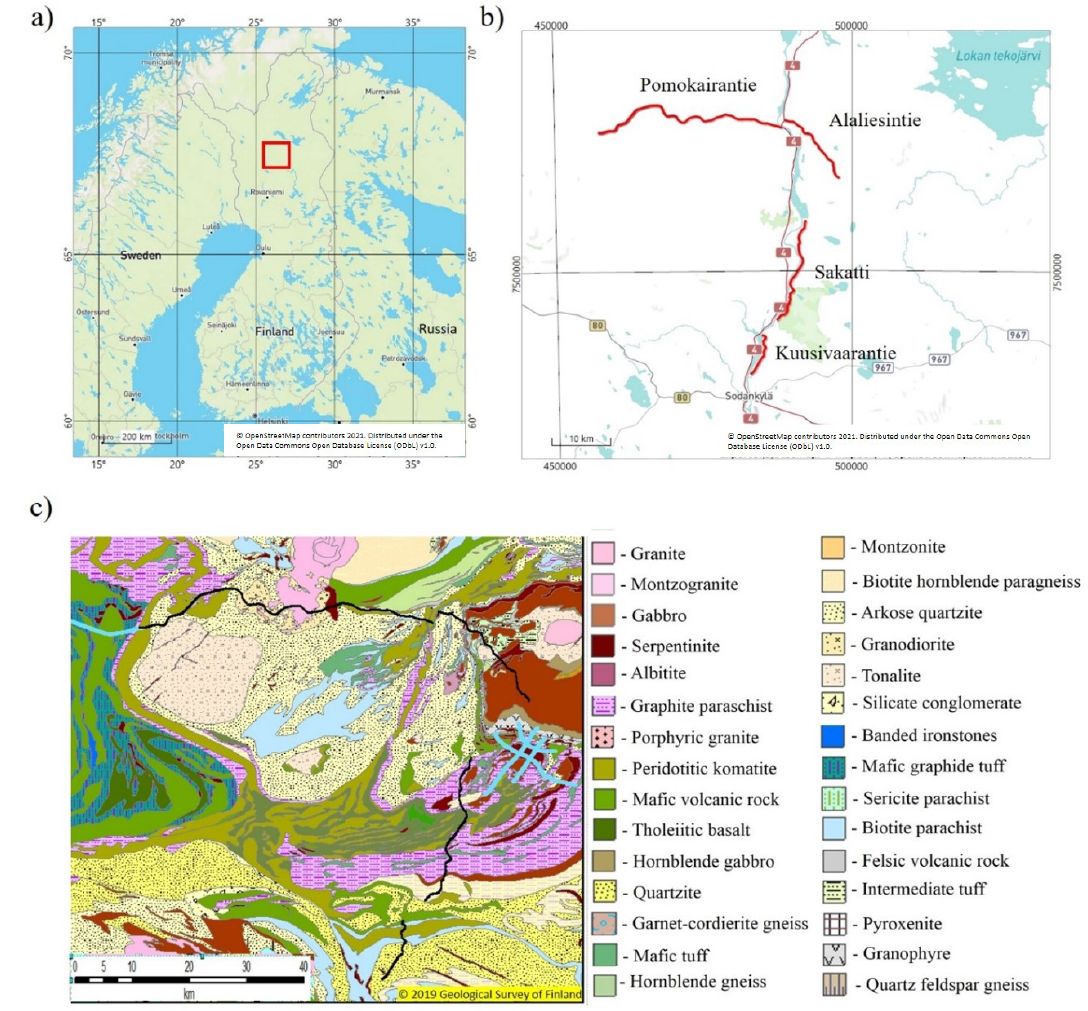
Figure 1. The XSoDEx seismic experiment: (a) geographical location of the study area (red rectangle); (b) the XSoDEx survey lines (coordinate system EUREF FIN TM35FIN); (c) geological map of the XSoDEx study area (Buske et al., 2019). The XSoDEx survey lines are shown with black lines. Previous seismic reflection survey lines are plotted with blue